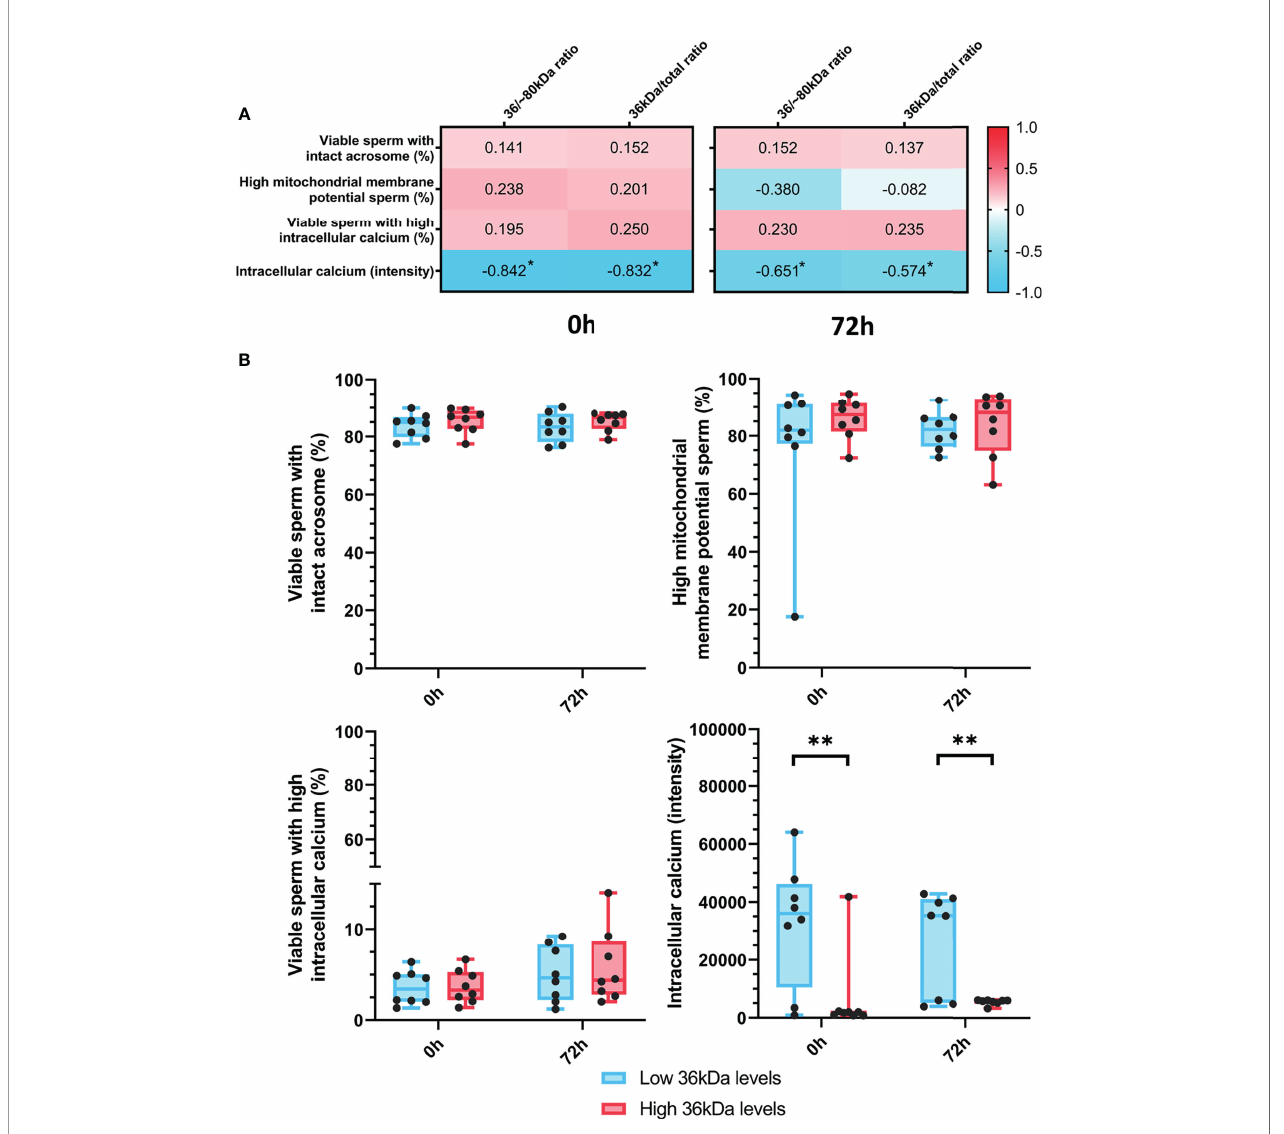
FIGURE 3 | (A) Correlation plot of sperm functionality parameters (including acrosome integrity, mitochondrial membrane potential and intracellular calcium) and 36/ ~80 kDa and 36 kDa/total ratios. Semen samples of 16 AI-boars (one ejaculate per boar) were evaluated immediately after semen samples arrived at the laboratory (0 h) and after storage/preservation at 17°C for 72 h. The color saturation of red to blue represents the correlation coef fi cients (R) from 1 to -1, respectively. Signi fi cant correlations ( P < 0.05) are marked with *. (B) Differences between groups with high and low levels of the 36 kDa band for the functionality parameters evaluated at both 0 h and 72 h. The box indicates the maximum and the minimum of each group and the thicker line the median. Each dot represents one semen sample. Signi fi cant differences ( P < 0.01) are marked with